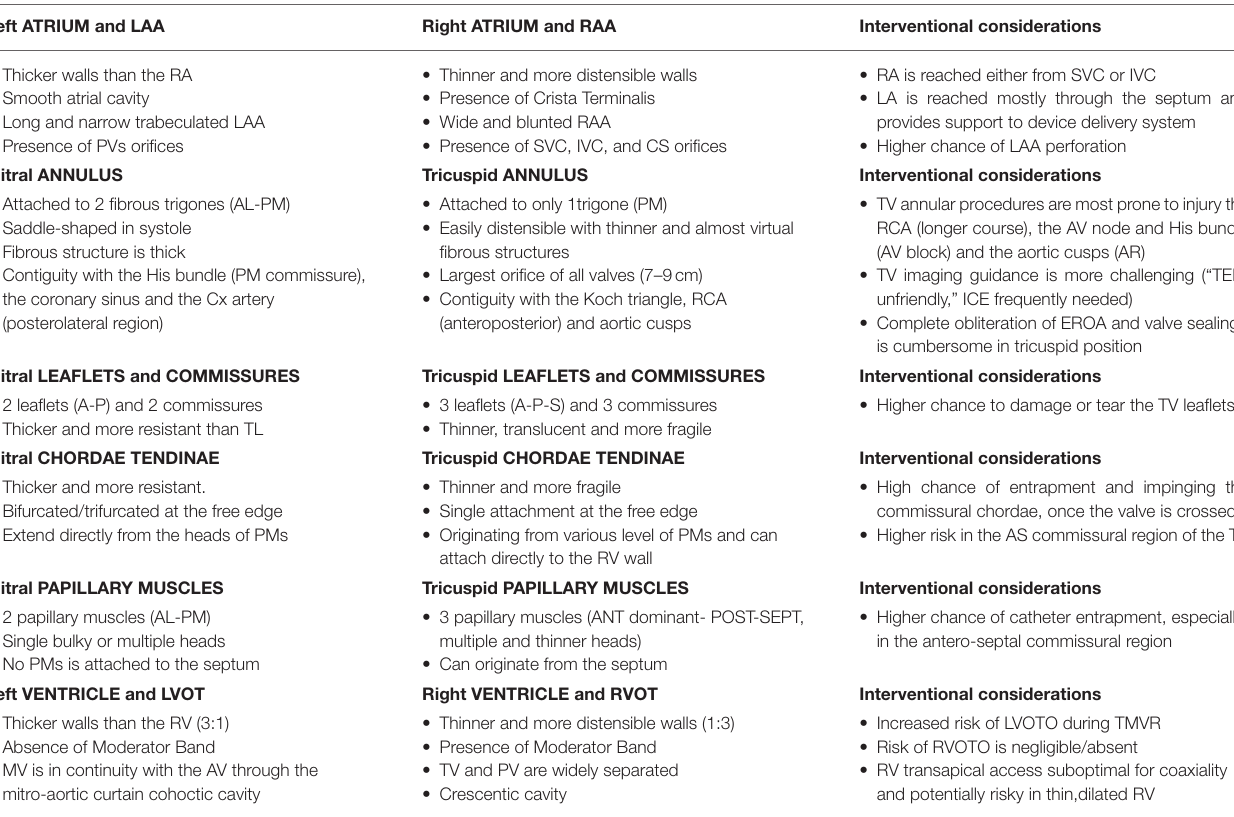
TABLE 1 | Similarities and anatomical differences between mitral and tricuspid valve apparatus, and their implications with regard to transcatheter treatments. Left ATRIUM and LAA